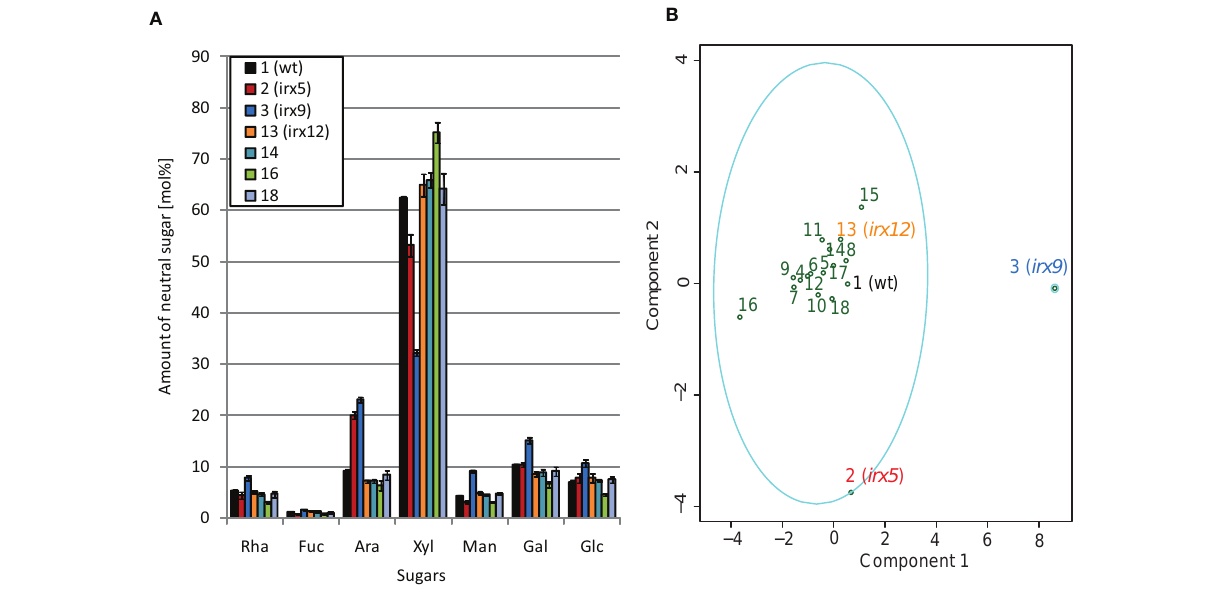
The ellipses indicate clustering of mutant sugar profiles based on the k-mediod algorithm. The number of clusters was estimated based on the silhouette width, i.e., the dissimilarity in sugar profiles as measured by the Euclidean distances between the profiles. Wild-type (black), and mutants affecting cellulose ( irx5 ; red), xylan ( irx9 ; blue), and potentially lignin ( irx12 ; orange) are indicated in